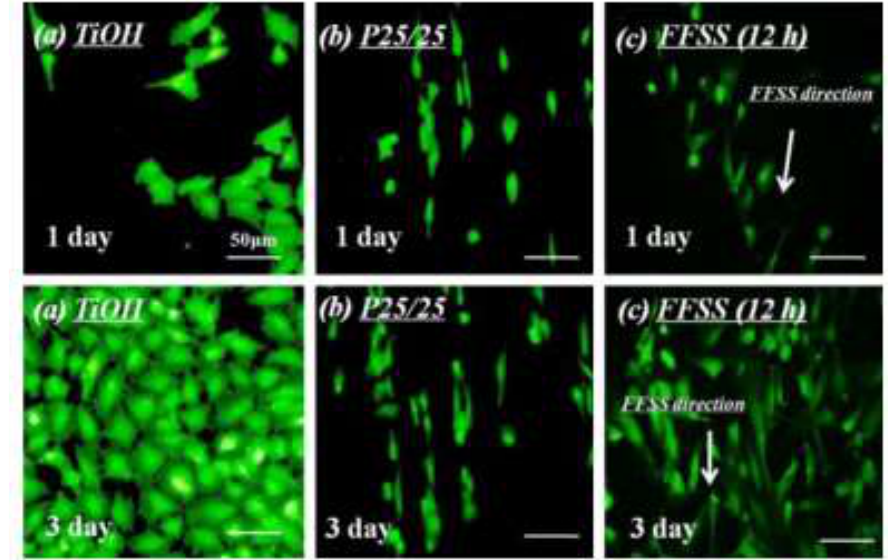
Figure 2. In the cited images, Li et al. prepared hyaluronic acid micro-strips with 25 µm size (samples were labeled as (b) P25/25) on the NaOH treated titanium surface to control the vascular endothelial cells’ morphology. The study demonstrated that the vascular endothelial cells controlled by P25/25 presented a similar morphology (elongation) with the vascular endothelial cells under 15 dyn/cm 2 fluid flow shear stress (samples were labeled as (c) FFSS, it is also the average blood flow shear stress in the human blood vessels). The vascular endothelial cells on the single NaOH treated titanium control (samples were labeled as (a) TiOH, and it was flat) showed round and polygonal morphologies which were different from the cells on P25/25 or under FFSS [22]. Copyright 2013, Elsevier.